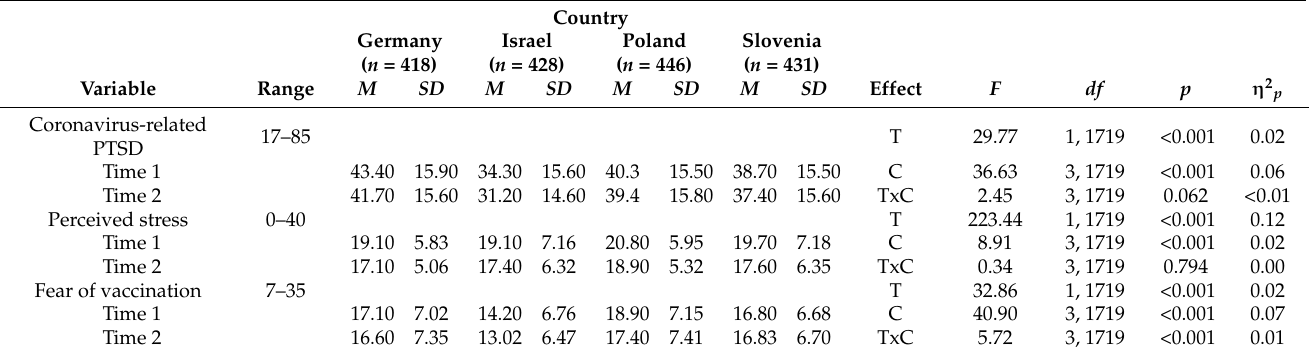
Table 2. Mean, standard deviation, and repeated measures two-way ANOVA statistics for study variables in representative samples of young adults from Germany, Israel, Poland, and Slovenia. Country Germany Israel Poland Slovenia ( n = 418) ( n = 428) ( n = 446) ( n =